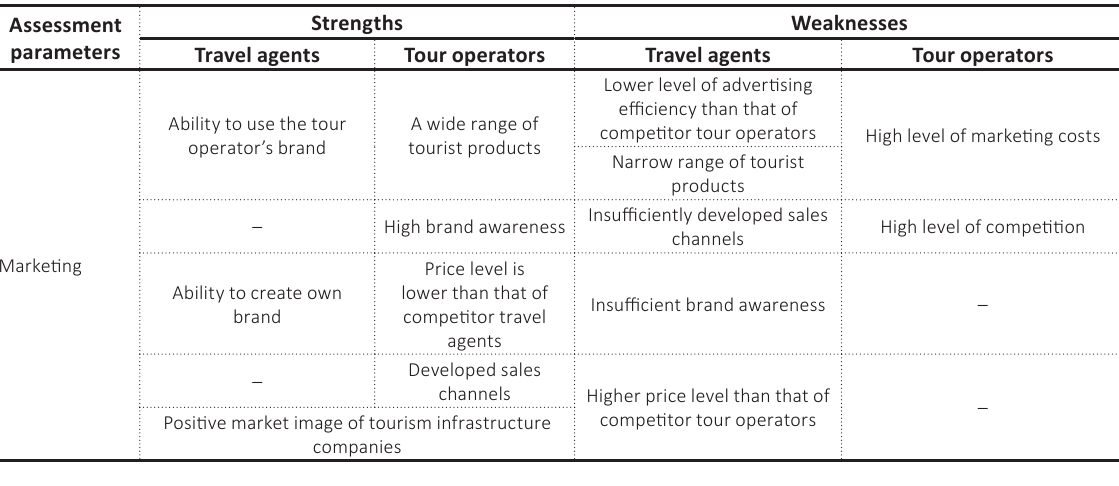
Table 7. Market opportunities and threats of leading tourism infrastructure